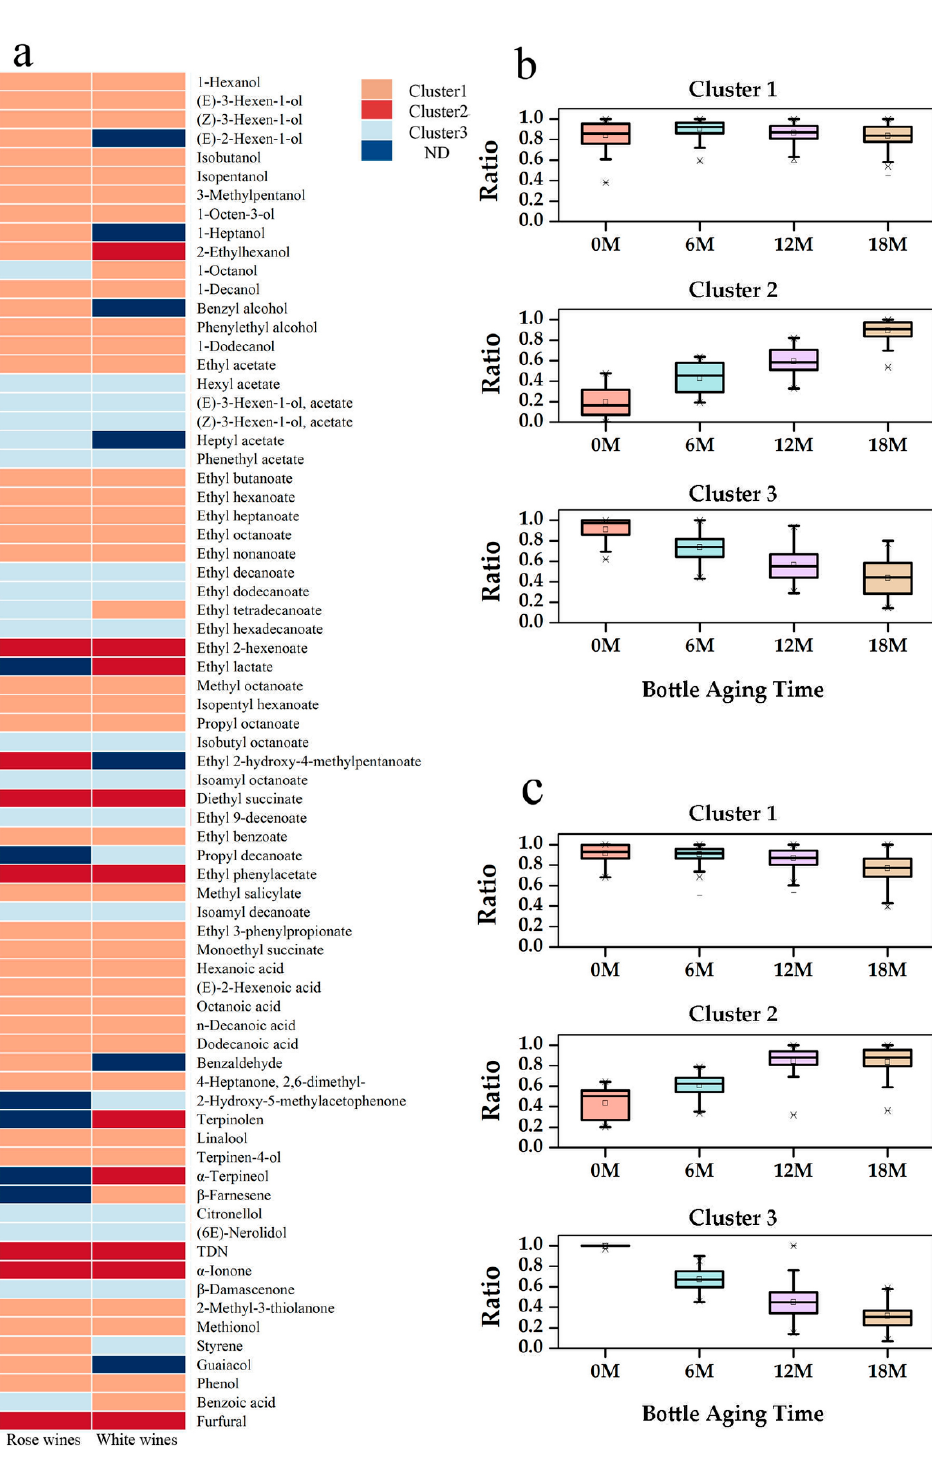
Figure 3. Change trends of volatile compounds during an 18-month bottle aging. ( a ) General volatile profile of rosé and white wines; ( b ) volatile compounds’ change trends in rosé wines; ( c ) volatile compounds’ change trends in white wines.